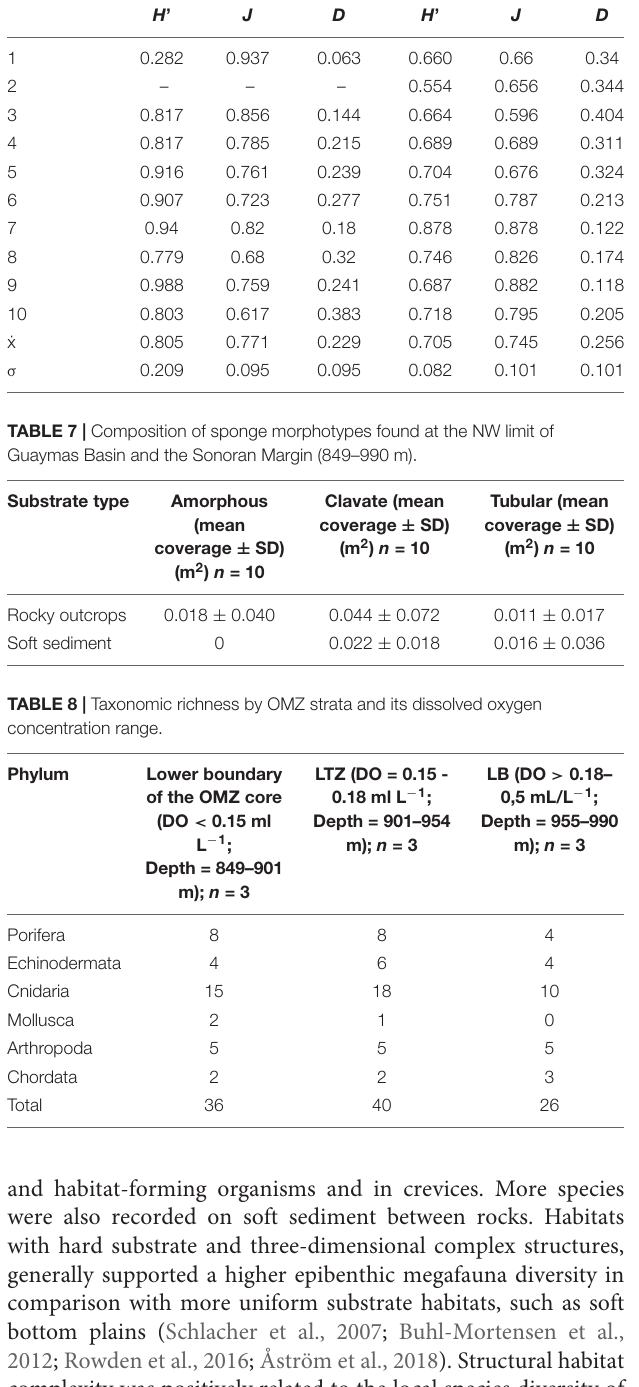
TABLE 6 | Shannon-Wiener diversity index (H (cid:48) ), evenness (J) and dominance calculated for each sample and per substrate. Sample ID